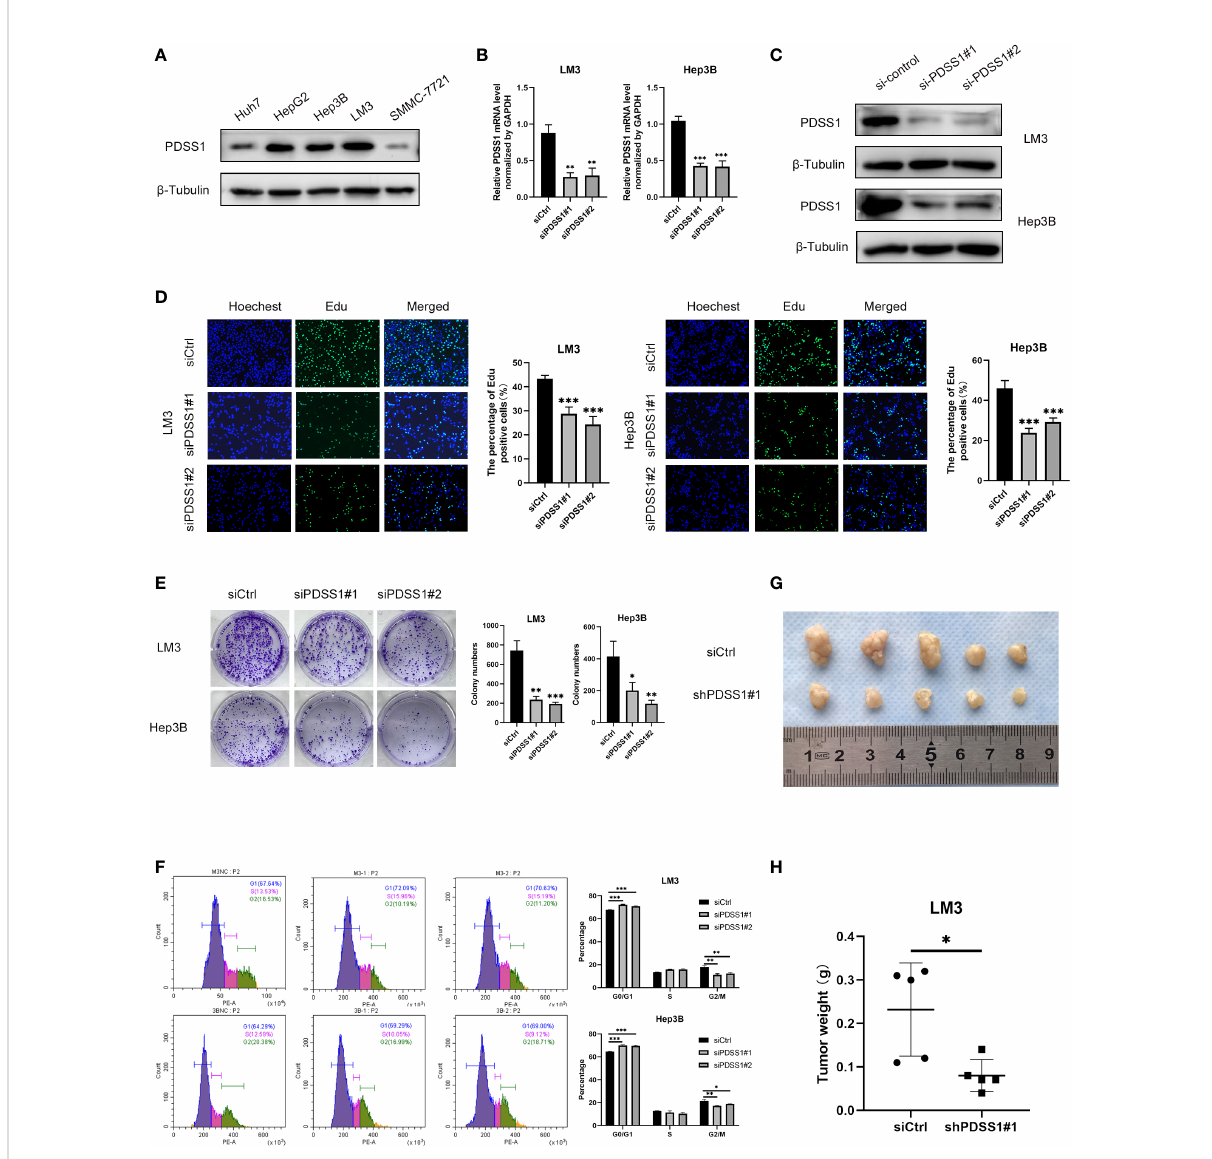
FIGURE 6 Knockdown of PDSS1 inhibited the proliferation, cell cycle, migration and invasion of HCC cells. (A) The level of PDSS1 was evaluated in various HCC cell lines by WB. (B, C) LM3 and Hep3B cells were transfected with siPDSS1, the level of PDSS1 was evaluated by qRT-PCR and WB. (D, E) EdU and Colony formation assays were performed to determine the proliferation of LM3 and Hep3B cells transfected with siCtrl or siPDSS1. (F) Cell cycle was detected in LM3 and Hep3B cells transfected with siCtrl or siPDSS1 by fl ow cytometry. (G, H) LM3 cell transfected with empty vector or shPDSS1 were injected into nude mice (n = 5) with the same concentration and amount. Data are expressed as the mean ± SD of three individual experiments. * p < 0.05, ** p < 0.01, *** p <